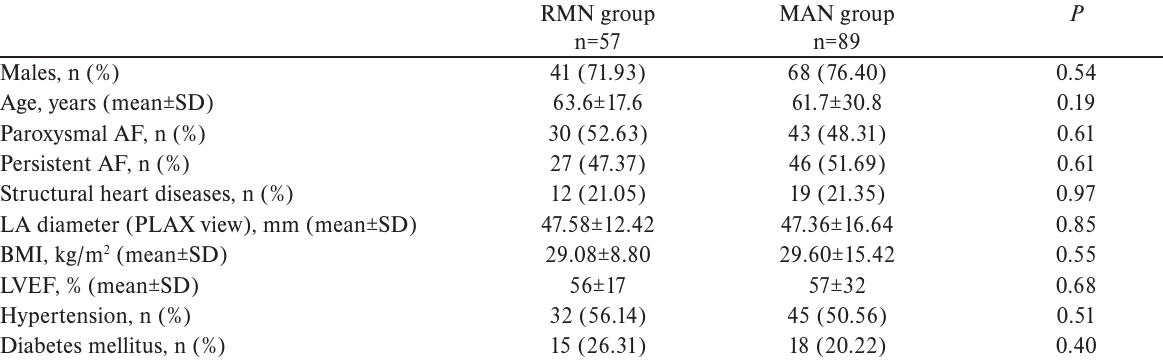
Table 1. Baseline characteristics of study groups.